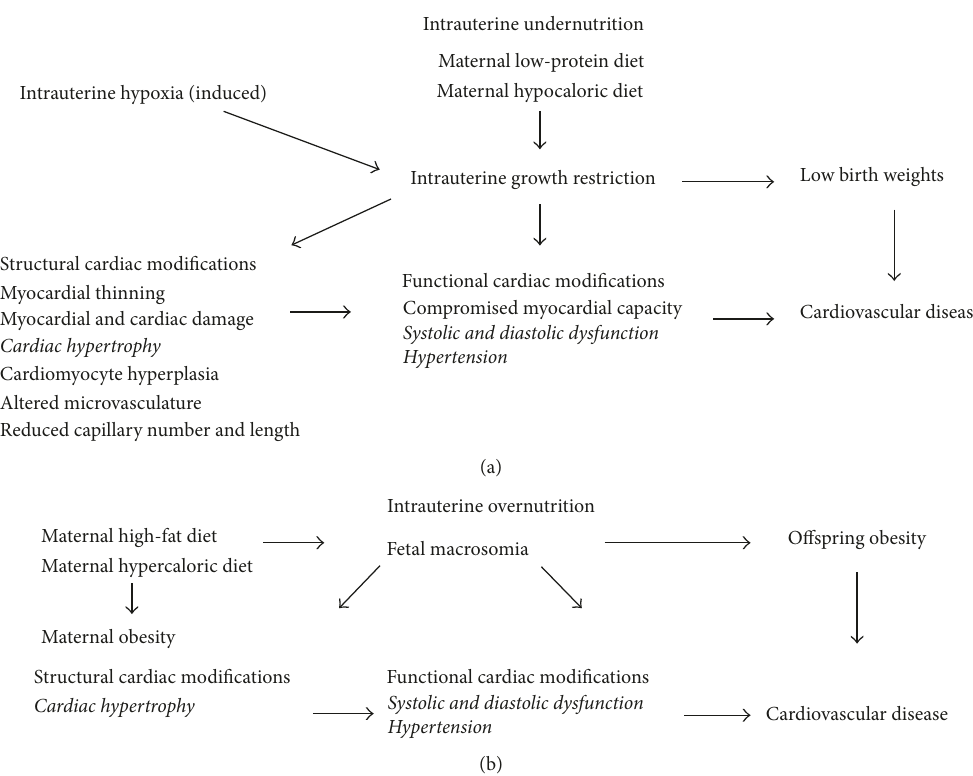
Figure 1: Nutritional programming of cardiovascular disease. Both intrauterine undernutrition (a) and overnutrition (b) alter offspring growth and induce structural and functional cardiac modifications that increase the risk for cardiovascular